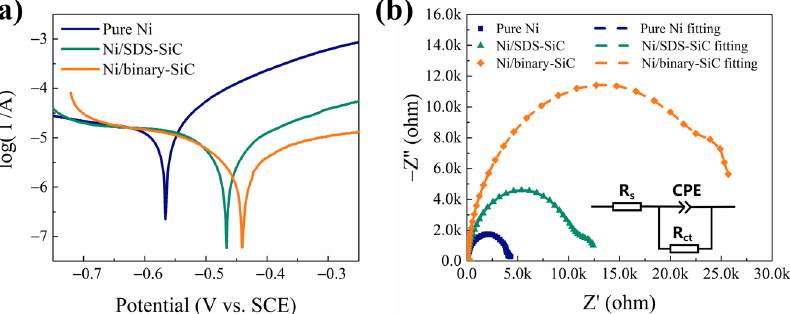
Figure 7. Electrochemical characterizations of composite coatings. ( a ) Tafel plots and ( b ) Nyquist plots. Inset is the electrical equivalent circuit. Table 2. Electrochemical parameters of the pure nickel, Ni/SDS - SiC and Ni/binary - SiC coatings pre- pared at the current density of 2.0 A dm −2 .